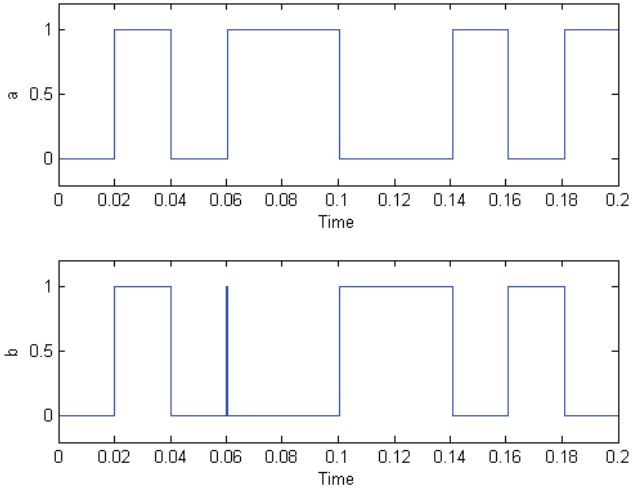
Figure 8. Carrier signal example indicative of the second situation.